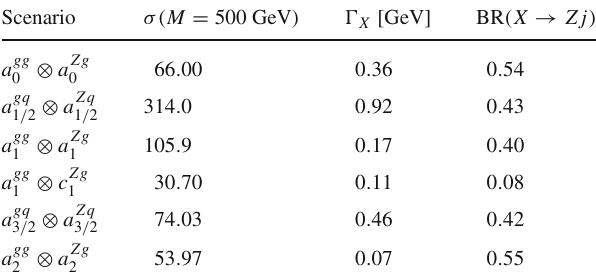
Table 2 Central value cross sections for the Z +jet scenarios discussed in Sect. 3 for coupling values of 10 − 1 . The results for P/CP-violating parameters are identical